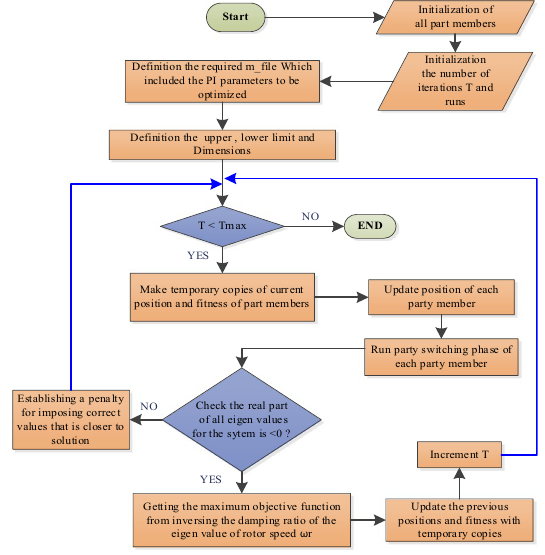
Fig. 4 Flow chart of PO